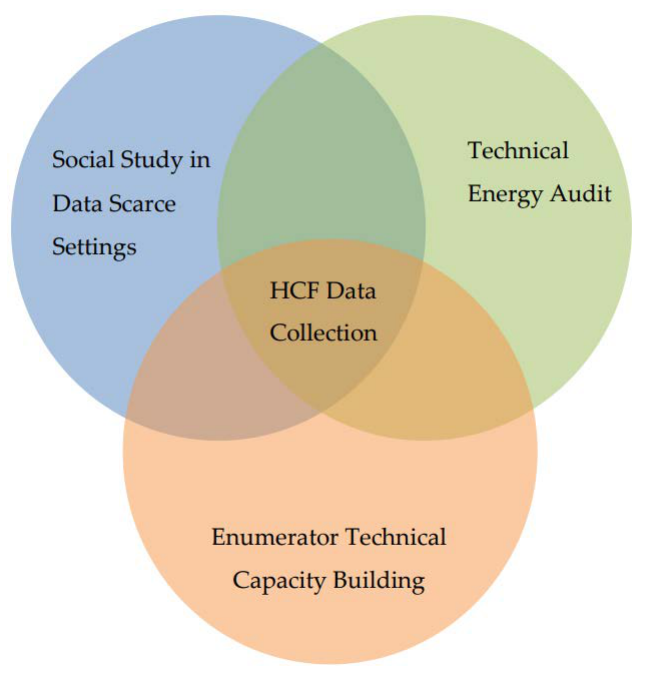
Figure 2. Integrated design of the portfolio-level, decentralized social study for energy